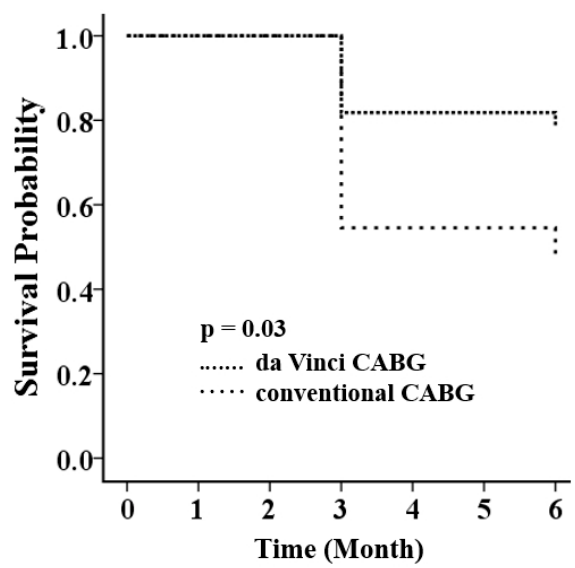
Figure 3. Kaplan–Meier survival analysis shows a significant reduction in the cumulative incidence of the composite of cardiovascular and renal endpoints at six months ( p = 0.03 by log-rank test), including all-cause mortality, non-fatal myocardial infarction, repeated revascularization, non-fatal stroke, the presence of chronic kidney disease stage 4 or 5, creatinine doubling, and a raise of the baseline creatinine >0.5 mg/dL in patients receiving da Vinci CABG as compared with those receiving conventional CABG. CABG = coronary artery bypass grafting. Table 3. Clinical outcomes at six months between two surgical modalities. Da Vinci Robotic Surgery Sternotomy Surgery p ( n = 22) ( n = 22)